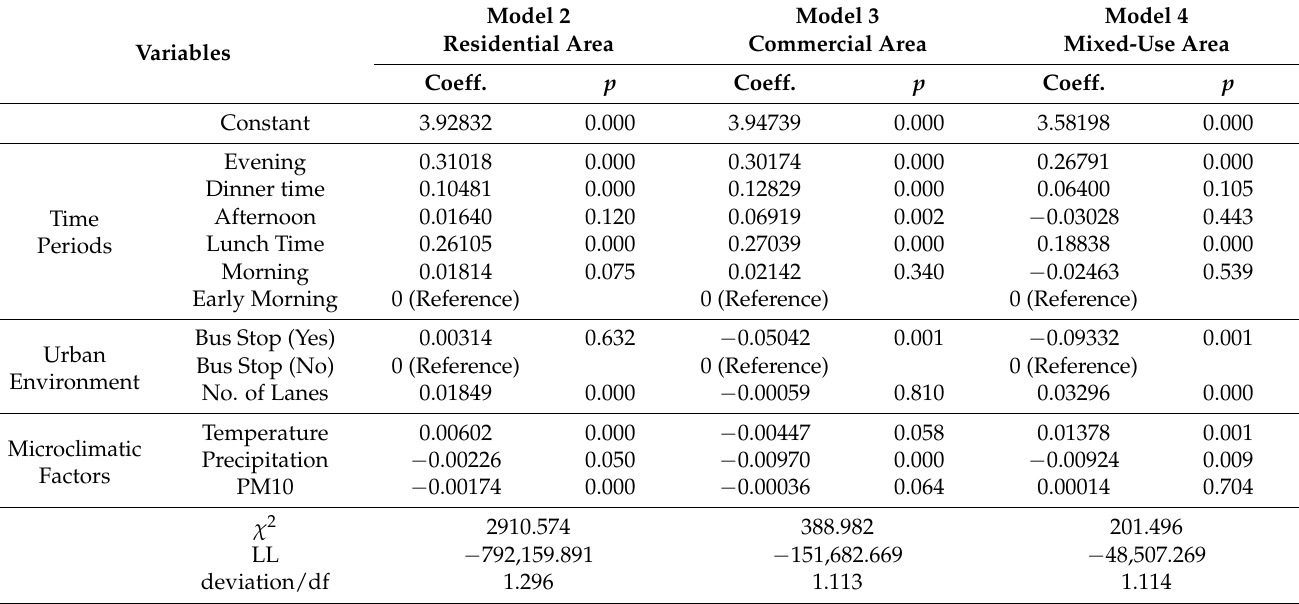
Table 9. Negative binominal regression analysis results by land-use